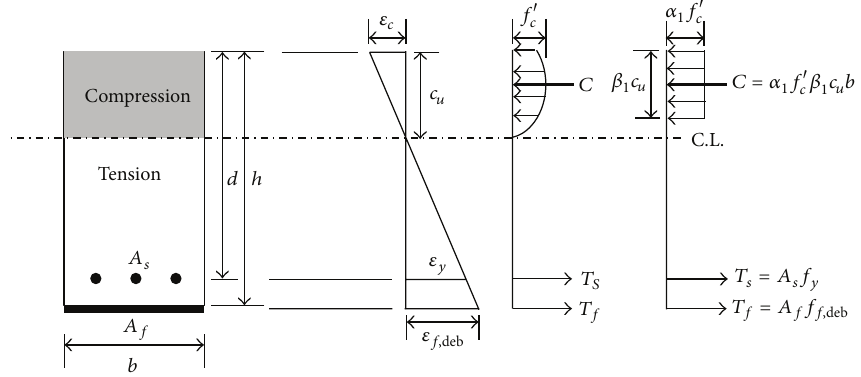
Figure 8: Analytical model at the ultimate